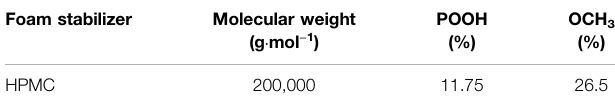
TABLE 3 | Property parameters of foam stabilizer.